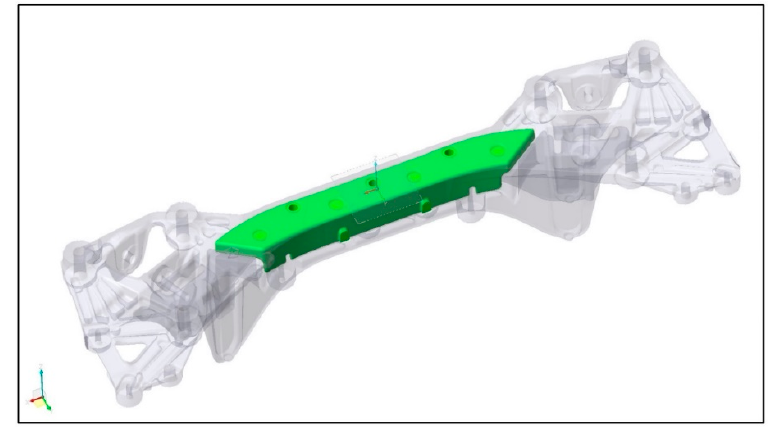
Figure 1. 3D design and schematic sketch of the section profile of ( a ) original crossbeam ( b ) modified crossbeam. The dimensions are expressed in (mm).